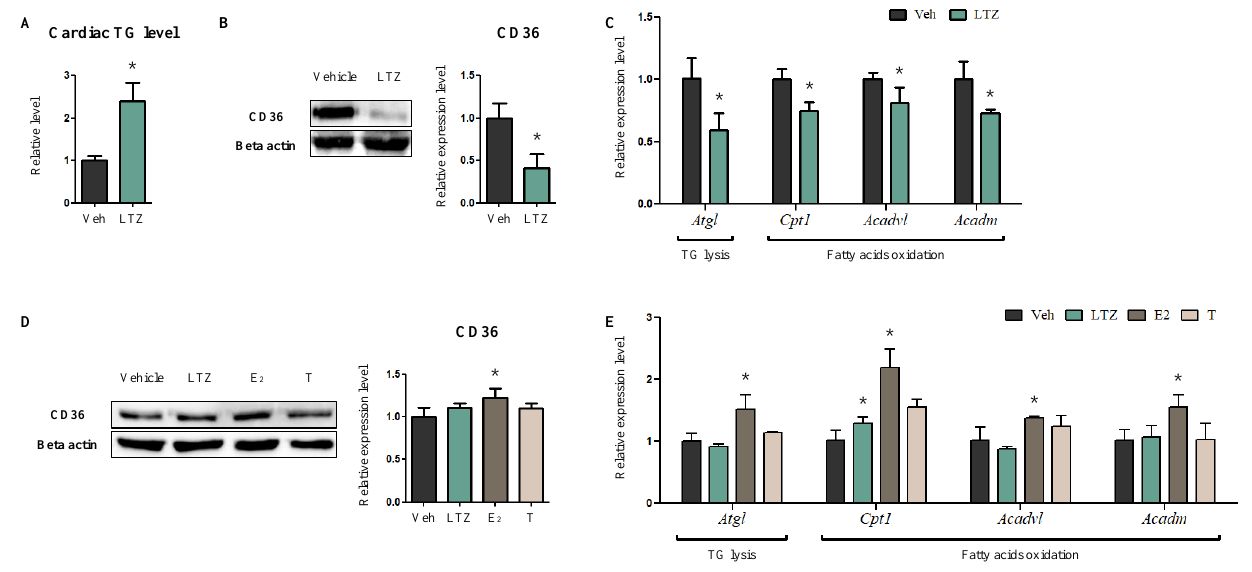
Figure 3. Letrozole alters all-around lipid metabolism, including TG accumulation and degradation and fatty acids uptake and oxidation in cardiomyocytes. ( A ) The degree of TG accumulation within LV was evaluated using a triglyceride measure assay kit. ( B ) The protein levels of fatty acids translocase were determined via Western blotting, with LV tissues. Beta actin was used as internal control. ( C ) mRNA levels of related genes of TG degradation and the β -oxidation gene were determined via quantitative RT-PCR with LV tissues. mRPLP0 was used as internal control. ( D ) The protein levels of fatty acids translocase were determined via Western blotting, with H9c2 cells. These cells were exposed to fatty acids (Palmitic acid 330 µ M, Oleic acid 660 µ M) and treated with LTZ, ethynylestradiol [E2] and testosterone [T], respectively. Beta actin was used as internal control. ( E ) mRNA levels of related genes of TG degradation and the β -oxidation gene were determined via quantitative RT-PCR with H9c2 cells, which was handled in the same fashion as ( D ). mRPLP0 was used as internal control. The values stand for means ± S.D. * p < 0.05 compared to Veh-rats or